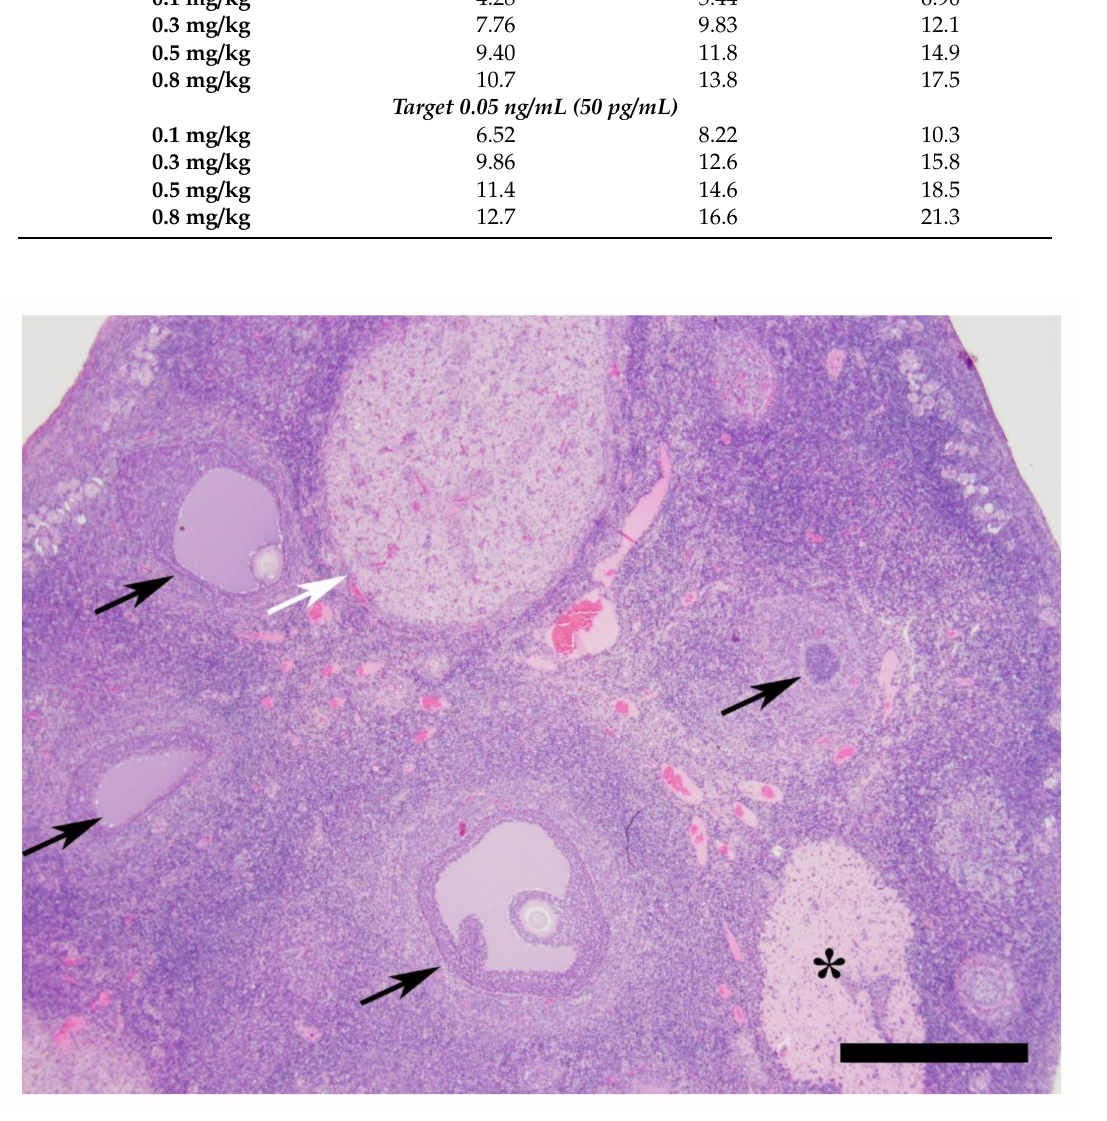
Figure 5. Feline ovary. The ovary contains a corpus luteum (white arrow), a corpus albicans (asterisk), and ovarian follicles at various developmental stages (black arrows). Hematoxylin & Eosin (H&E) stain. Bar = 500 µ